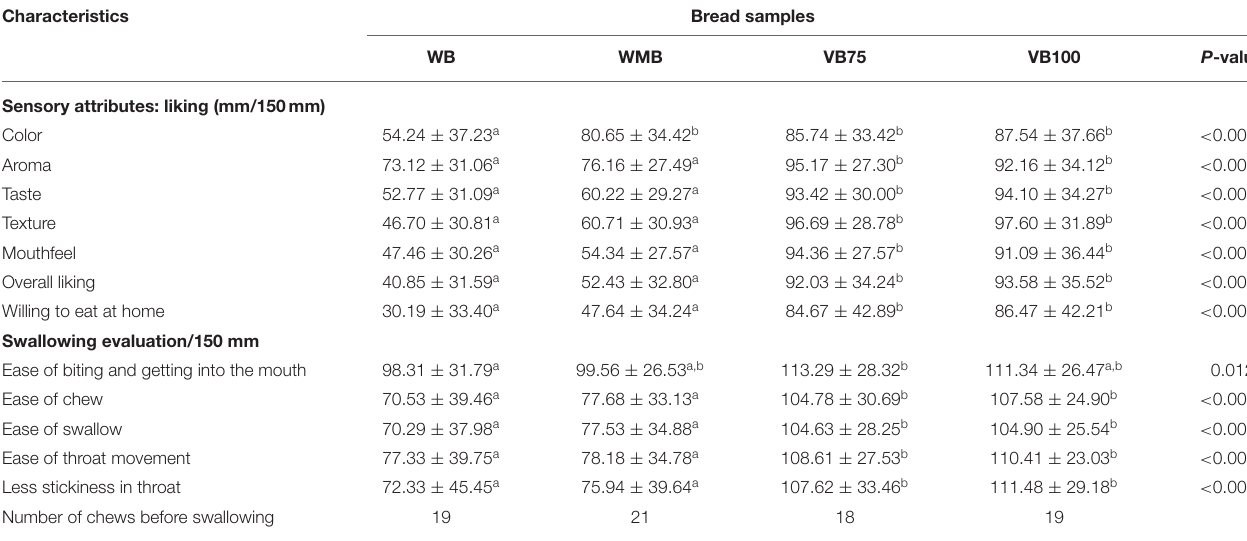
TABLE 4 | Sensory liking and swallowing perceptions of the four breads by participants ( n = 50).